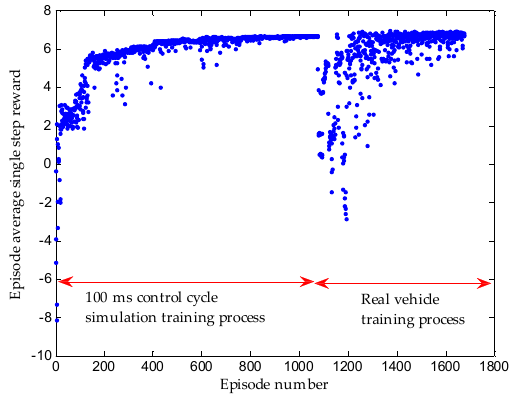
Figure 16. Real vehicle training migration.